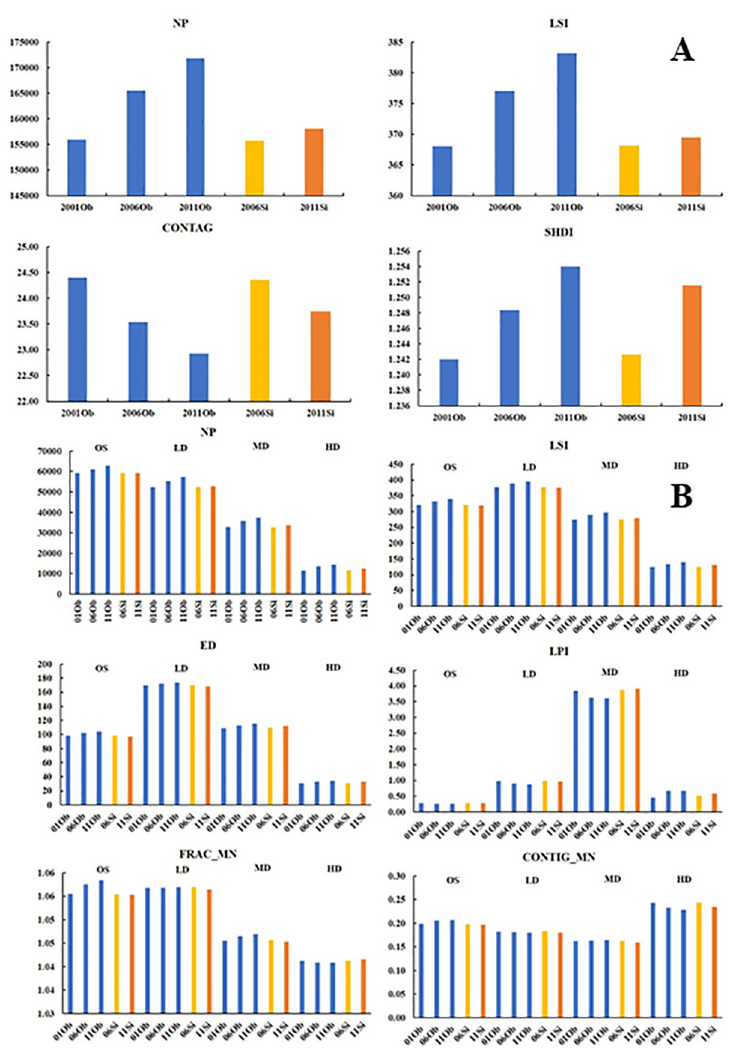
Fig 9. Landscape metrics over time. (A) Landscape metrics in landscape scale in observed (2001, 2006, 2011) and simulated maps (2006, 2011). (B) Landscape metrics in class scale in observed (2001, 2006, 2011) and simulated maps (2006, 2011). “Ob” represented observed map, and “Si” represented simulated